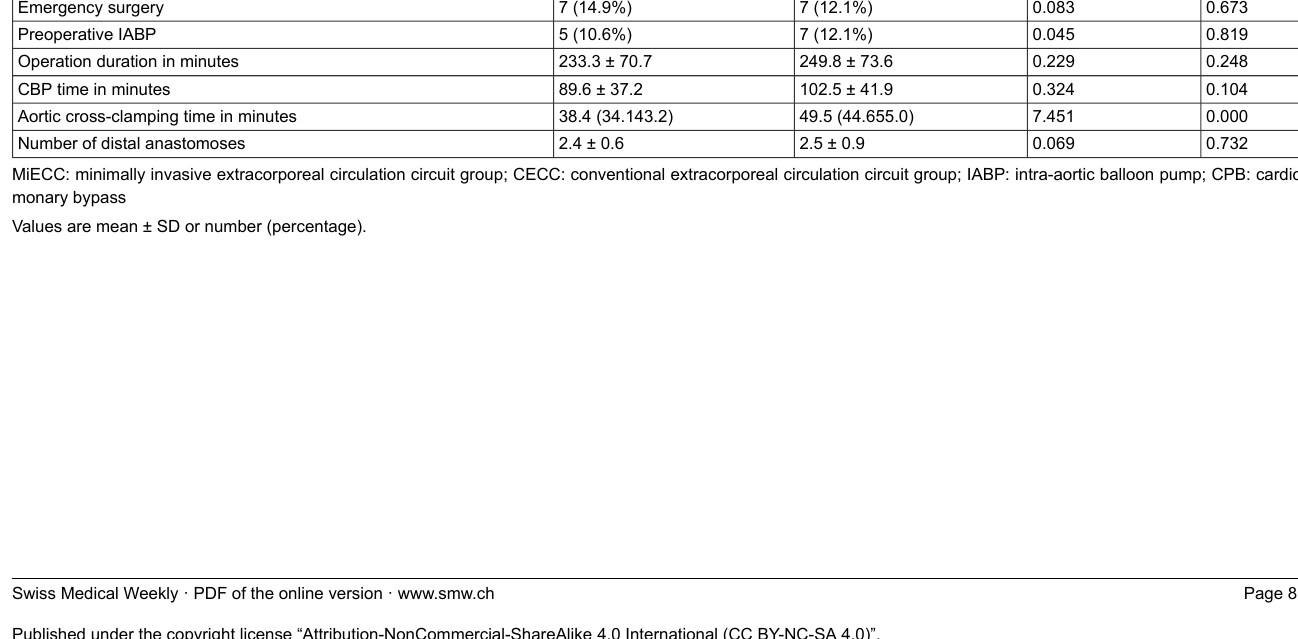
Table S2: Intraoperative data before propensity score matching and before inverse probability of treatment weighting (IPTW). Intraoperative